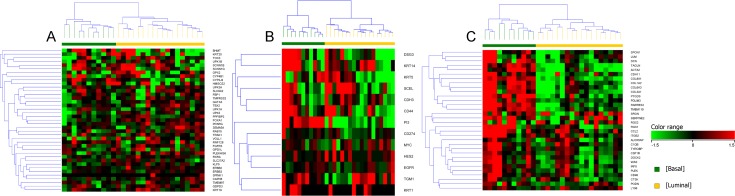
Supervised clustering of genes implicated in human iUC that assign luminal, basal and infiltrated phenotype to tumors.A list of reference genes reported to assign luminal (A), basal (B), and infiltrated (C) subtypes in human iUC was used to query the gene expression patterns in the canine iUC dataset. Supervised clustering of the data displays similar patterns of these genes in canine iUC as reported in human iUC [5,8,17].